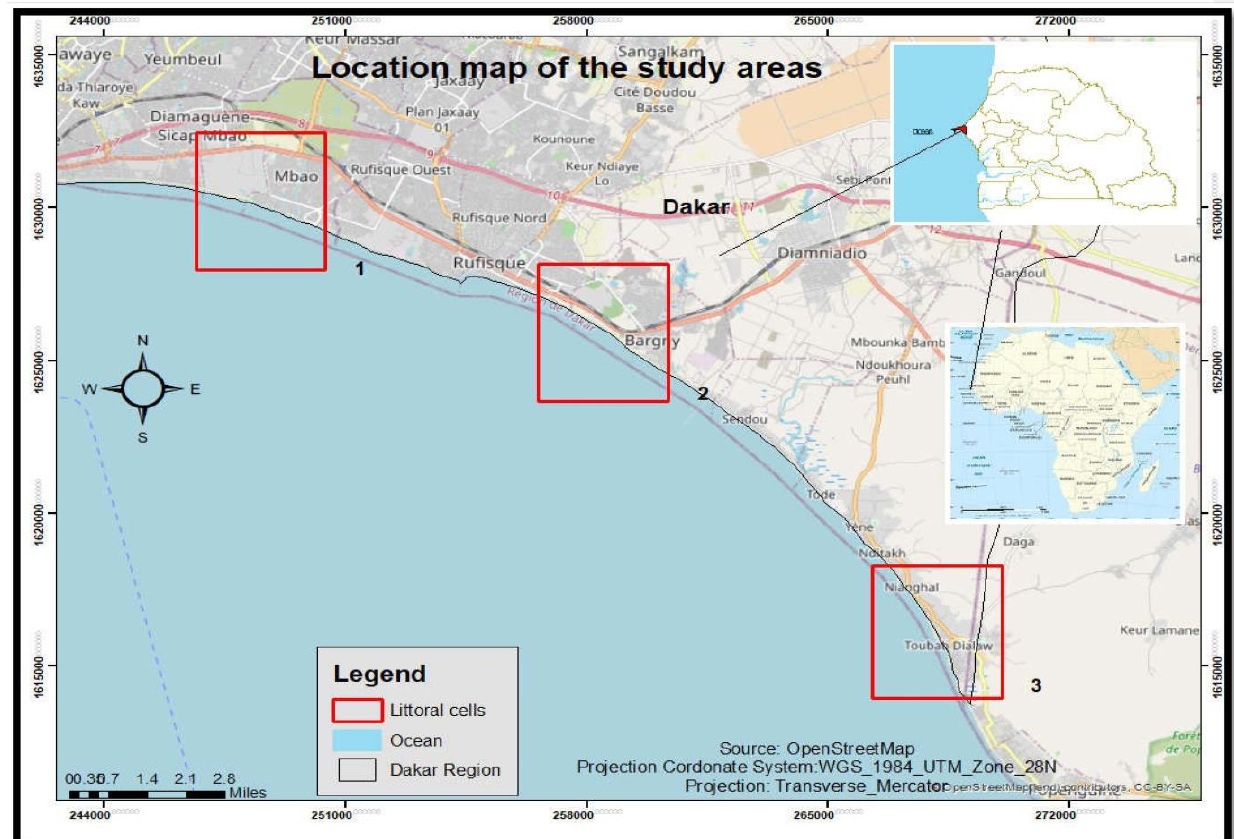
Figure 1. Location map of the study areas. Source: OpenStreetMap.